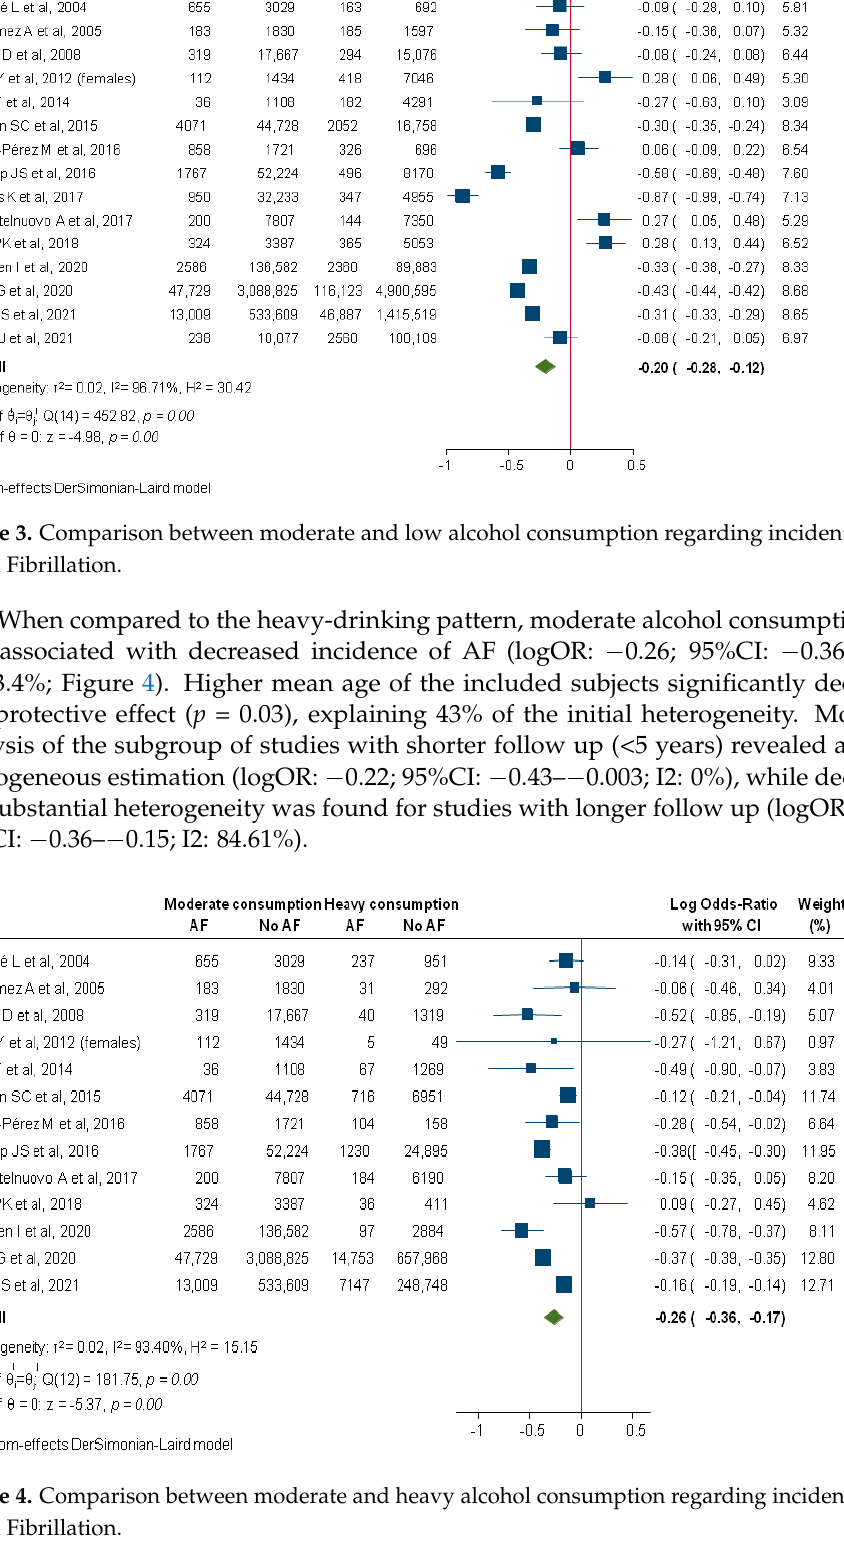
Figure 4. Comparison between moderate and heavy alcohol consumption regarding incident AF. Atrial AF, Atrial Fibrillation.